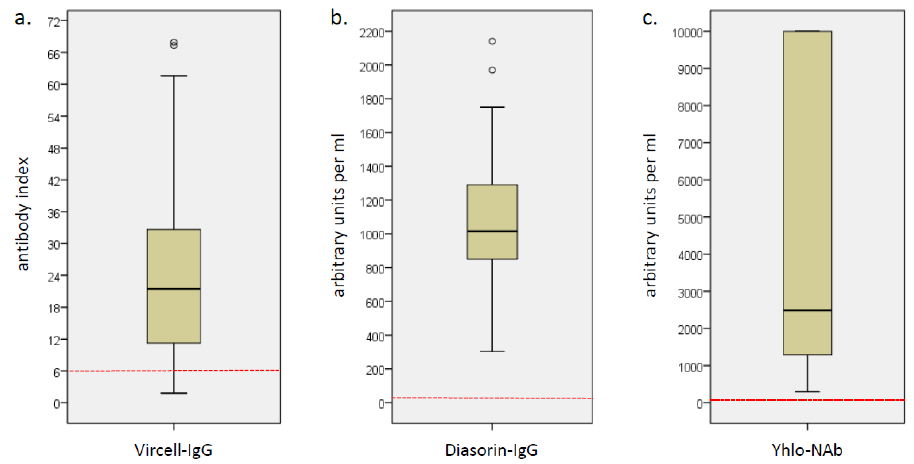
Figure 1. Box plots of the SARS-CoV-2 antibody levels measured with ( a ) Vircell-IgG, ( b ) DiaSorin-IgG and ( c ) Yhlo-NAb. The red dotted line shows the threshold for positivity. Open circles depict outliers. Gender, age and BMI did not show an association with the antibody levels or with the AUCs of the AEs (Table S1). An exception was muscle pain after the boost vaccination that correlated significantly with age (r = 0.235, p = 0.036). In contrast, subjects who took anti-inflammatory medication after the boost dose had significantly higher AUCs of injec- tion site pain, chills, malaise, fatigue, headache, pain in the limbs and elevated tempera- ture than patients who did not. The antibody levels were not affected by this use of anti- inflammatory drugs (Table S2). A comparison of the mean antibody levels in subjects with and without a specific AE revealed the following (Table 2): After the prime vaccination, only subjects with head- aches had (significantly) higher antibody levels than those without (Vircell-IgG: 26.7 vs. 17.9 AI, p = 0.042; DiaSorin IgG: 1310 vs. 1005 AU/mL, p = 0.011; Yhlo-NAb: 6689 vs. 2345 AU/mL, p = 0.062). After the boost vaccination, the mean Vircell-IgG levels were signifi- cantly higher in subjects suffering from malaise (29.1 vs. 18.6 AI, p = 0.027) and fatigue (22.4 vs. 15.1 AI, p = 0.039), whereas the DiaSorin-IgG levels were significantly higher in subjects with local lymphadenopathy (1220 vs. 1000 AU/mL, p = 0.041) and nausea (1310 vs. 1010 AU/mL, p = 0.036). Importantly, however, the Yhlo-NAb surrogate neutralization assay did not reveal significantly elevated antibody levels in any of the patient groups. Table 2. Median SARS-CoV-2 antibody levels stratified after the occurrence of adverse effects.